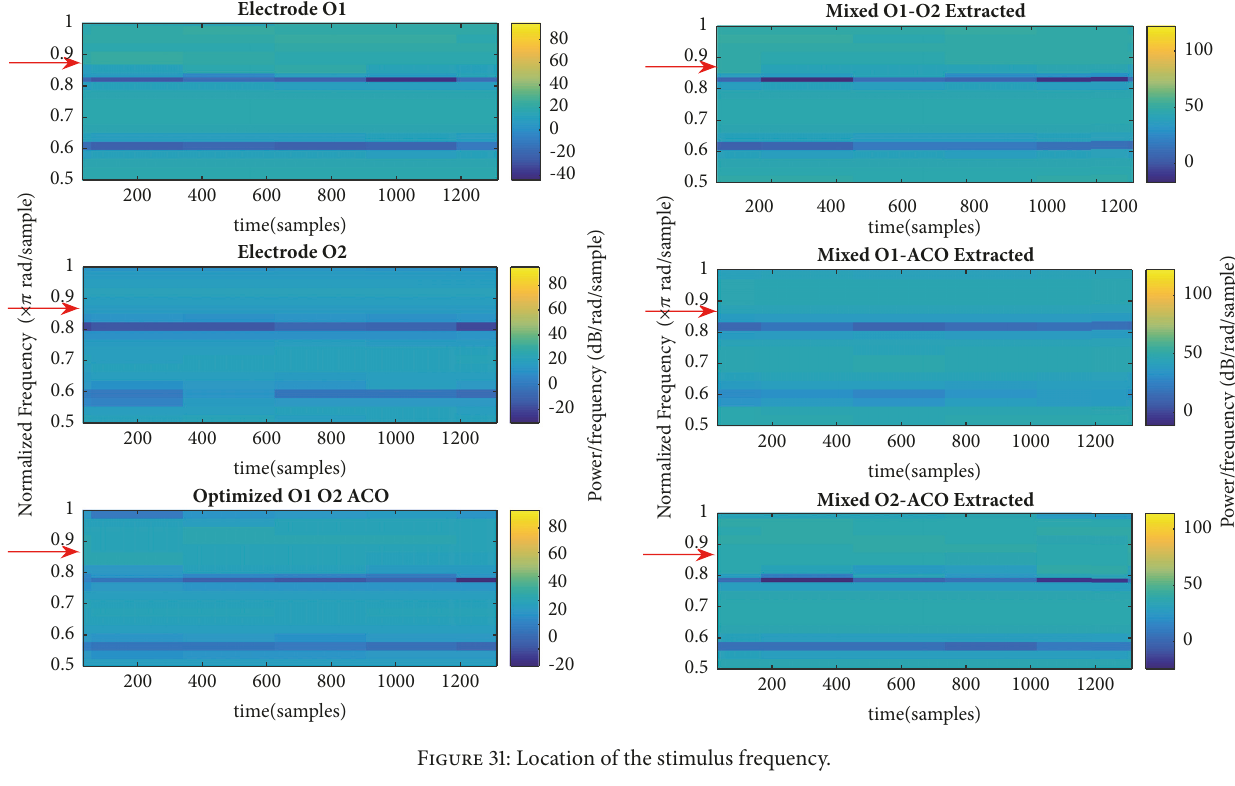
Figure 31: Location of the stimulus frequency.